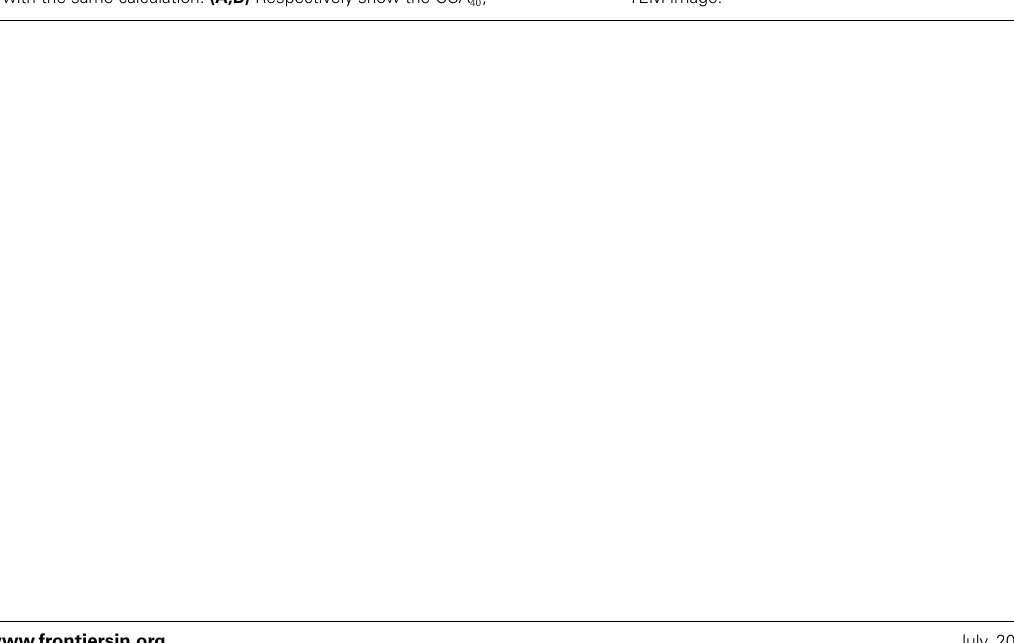
FIGUREA4 | Comparison of the size of distribution of operating range ofTEM image and simulated reaction spaces. We provide histograms of the size of the operating range of CCA 40 , s0–s1200, made of the same sample number withTEM images (161 images of TEM or 161 images produced by each simulation) to normalize them with the same calculation. (A,B) Respectively show the CCA 40 ,